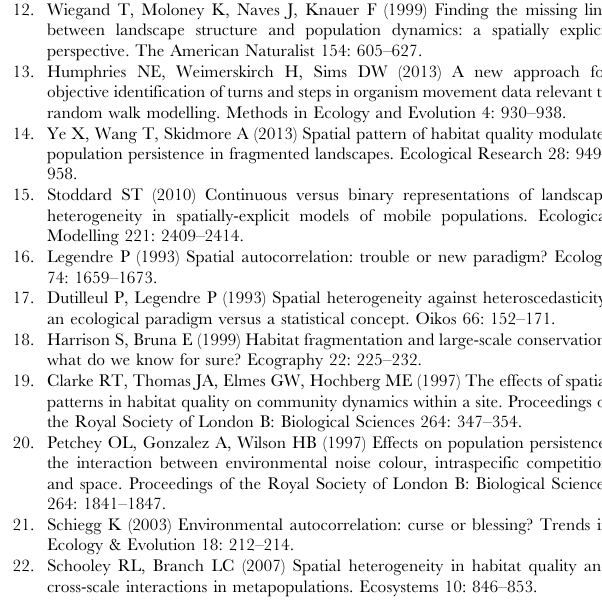
Figure S1 Sample patterns of spatial distribution of individuals residing in high-quality cells under different landscape scenarios. (DOCX) Figure S2 Sample patterns of spatial distribution of individuals experiencing competition under different landscape scenarios. (DOCX) Table S1 Factorial ANOVAs on each of the five response variables under different scale of spatial autocorrelation in habitat quality and species’ environmental tolerance and movement capacity. (DOCX) Text S1 Testing for the effect of different initial age- structures on model output. (DOCX) Text S2 Calculation of the generalized eta-squared in factorial